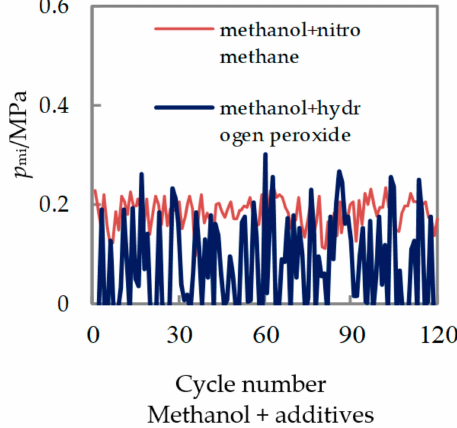
Figure 11. Cyclic variations of Pmi with di ff erent